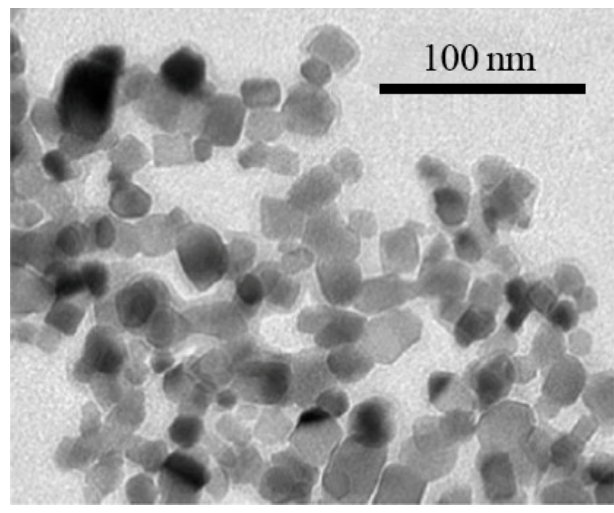
Figure 12. TEM demonstration of titanium oxide in water. Reproduced from [201], Elsevier: 2018.